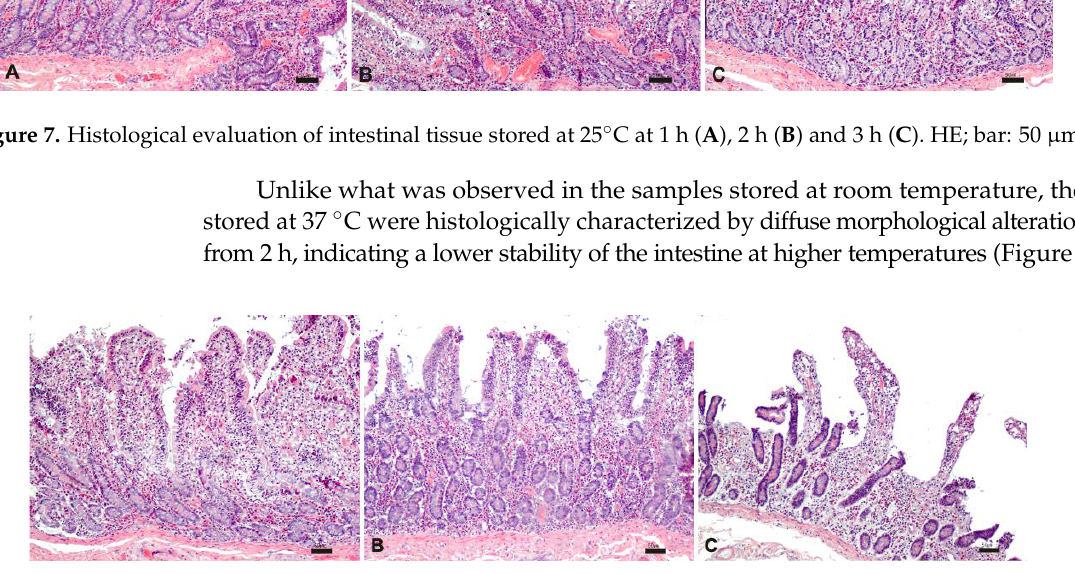
Figure 7. Histological evaluation of intestinal tissue stored at 25°C at 1 h ( A ), 2 h ( B ) and 3 h ( C ). HE; bar: 50 µm. Figure 8. Histological evaluation of intestinal tissue stored at 37°C at 1 h ( A ), 2 h ( B ) and 3 h ( C ). HE; bar: 50 µm. Based on the histological evaluation, the tissue and cell morphology of intestinal mucosa retain similar features as those described at time zero for about 3 h by being kept at 25 °C in PBS. In general, when performing ex vivo tests, the aspect related to the con-